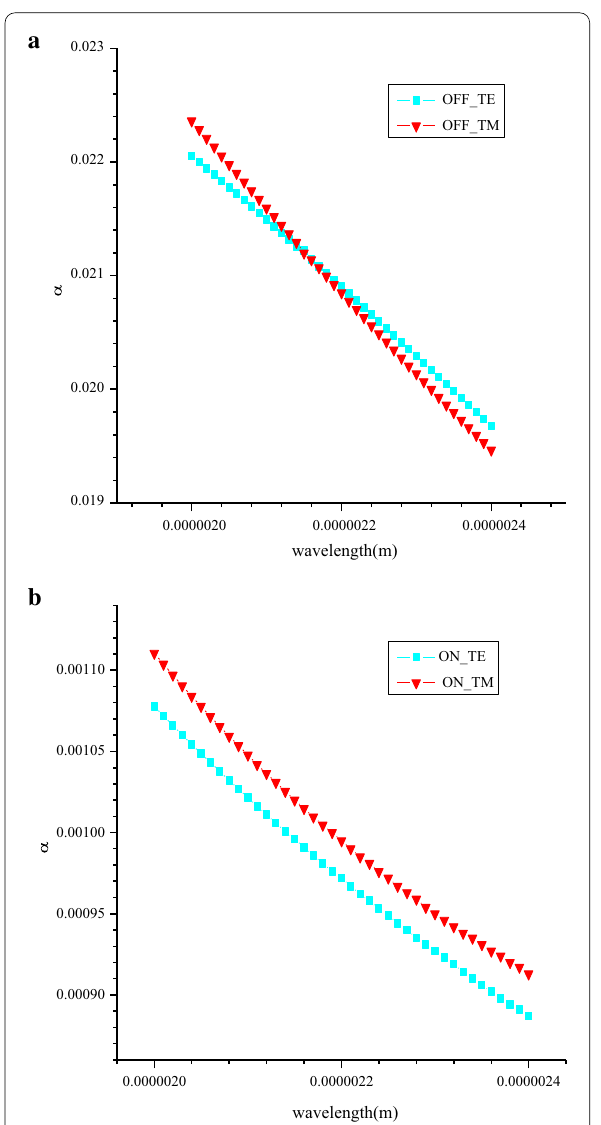
Fig. 6 Absorption coefficients ( α ) of TE and TM have an almost identical fluctuation with the change of wavelength at “OFF” state ( a ) and “ON” state ( b )